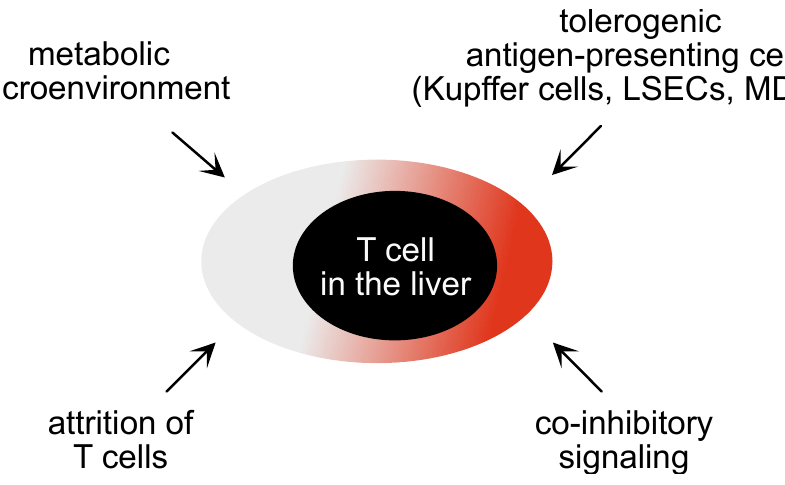
Figure 1. Schematic illustration of factors locally influencing T cell function in the liver .